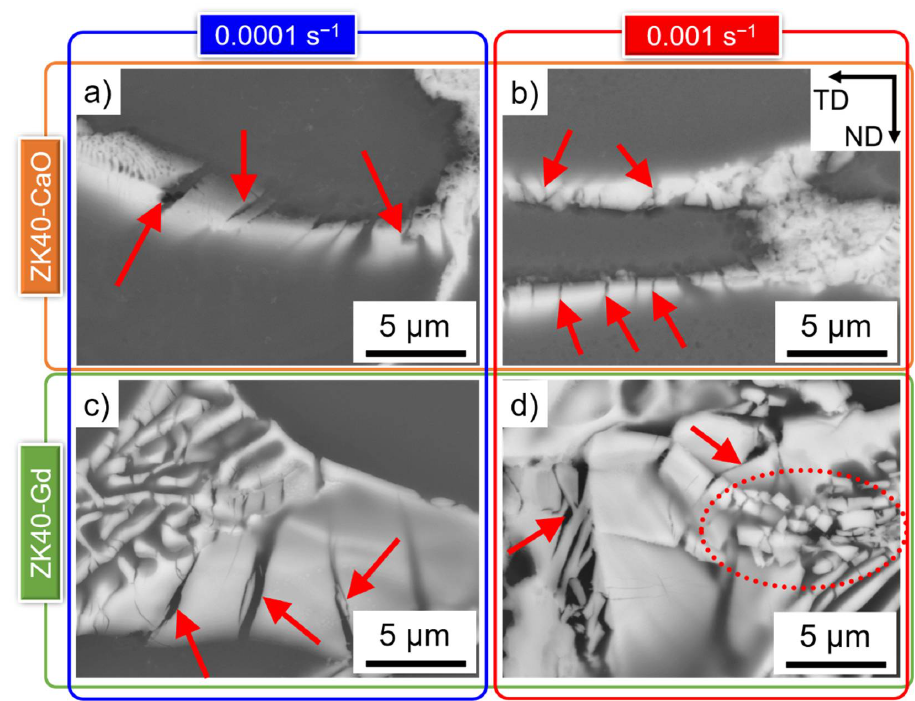
Figure 7. Backscattered electron micrographs of the fractured intermetallic compounds in: ( a , b ) ZK40-CaO; and ( c , d ) ZK40-Gd, deformed at 0.001 s −1 and: ( a , c ) 250 °C; and ( b , d ) 300 °C. Red arrows indicate cracks. The fragmented intermetallic compound is indicated by the dashed red ellipse. ND and TD indicate the compression and transversal directions, respectively.